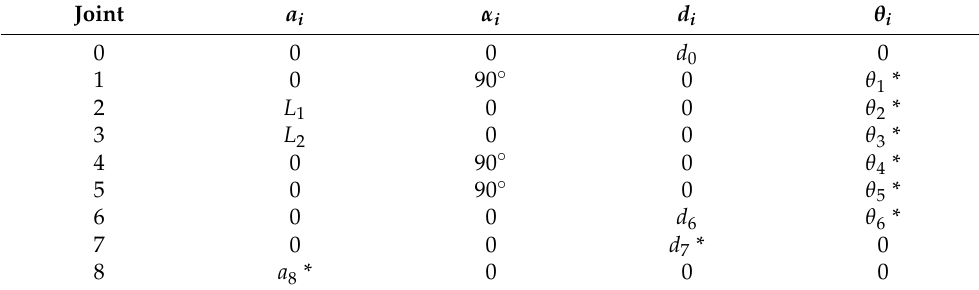
Table 2. DH parameters of the